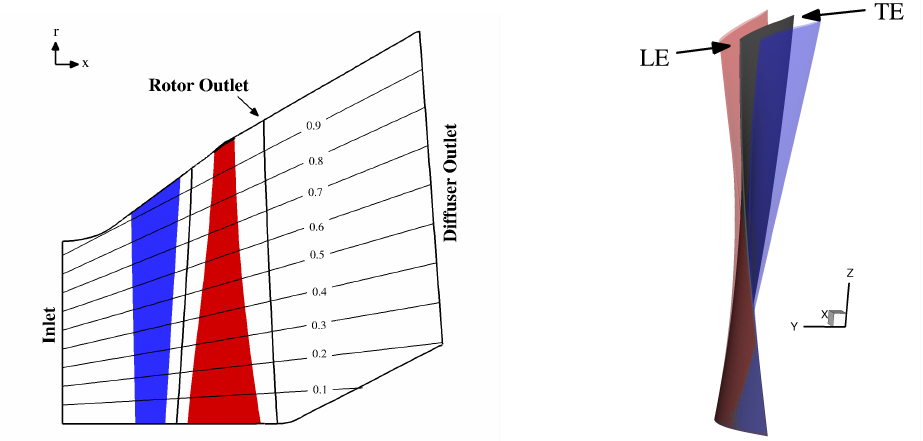
Figure 1. Sketch of the configuration in S2 plane ( left ) and first rotor bending mode ( right ).